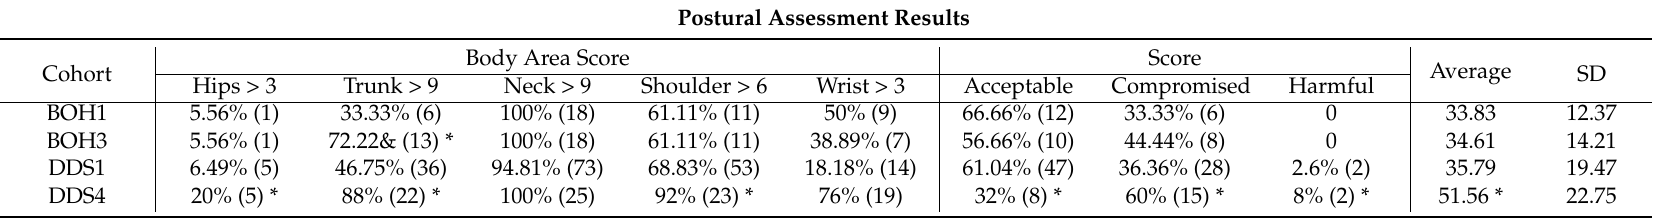
Table 8. Postural assessment results of students by cohort in percentage. Cut-off scores for specific body regions were calculated based on the ideal score for that